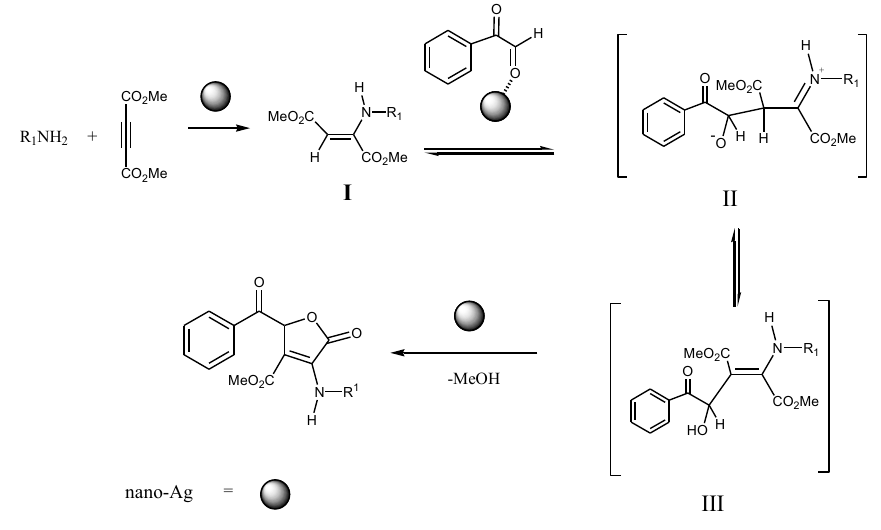
Scheme 2. Schematic mechanism for the catalytic activity of Ag nanocatalyst for the synthesis of furans for Ag nanoparticles (JCPDS No.